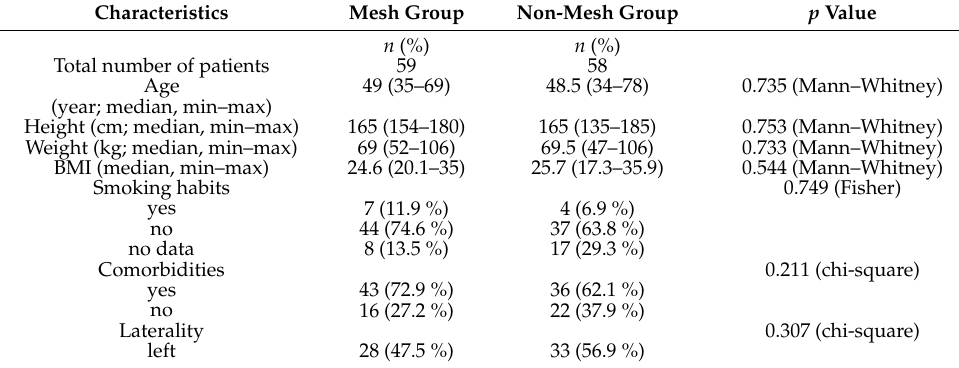
Table 1. Table 1. The patient and tumor characteristics.